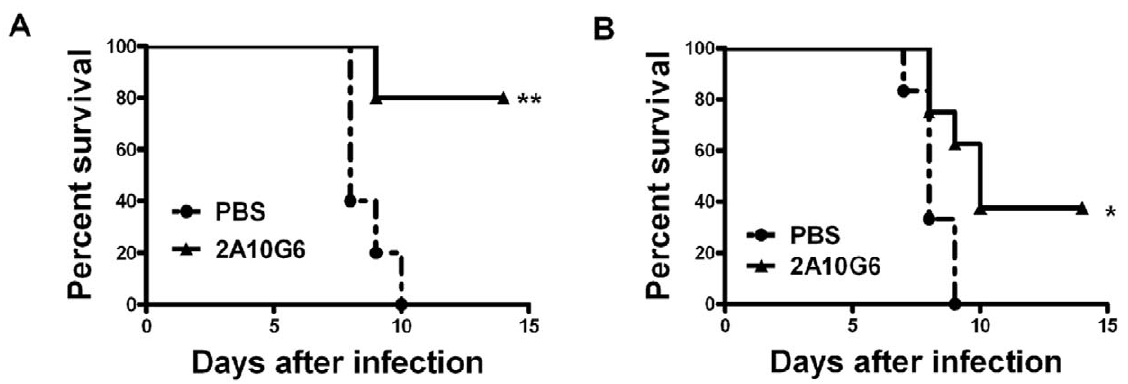
Figure 6. Protetcion of 2A10G6 against WNV in mice. Group of 4-week-old Balb/C mice were administrated with 200 m g of 2A10G6 one day before (A) or after (B) challenge with 40 PFU of WNV. PBS was included as a negative control. Kaplan–Meier survival curves were analyzed by the log- rank test and compared to curves of the PBS controls. Significant differences are indicated by asterisks (** p , 0.01 and * p , 0.05).